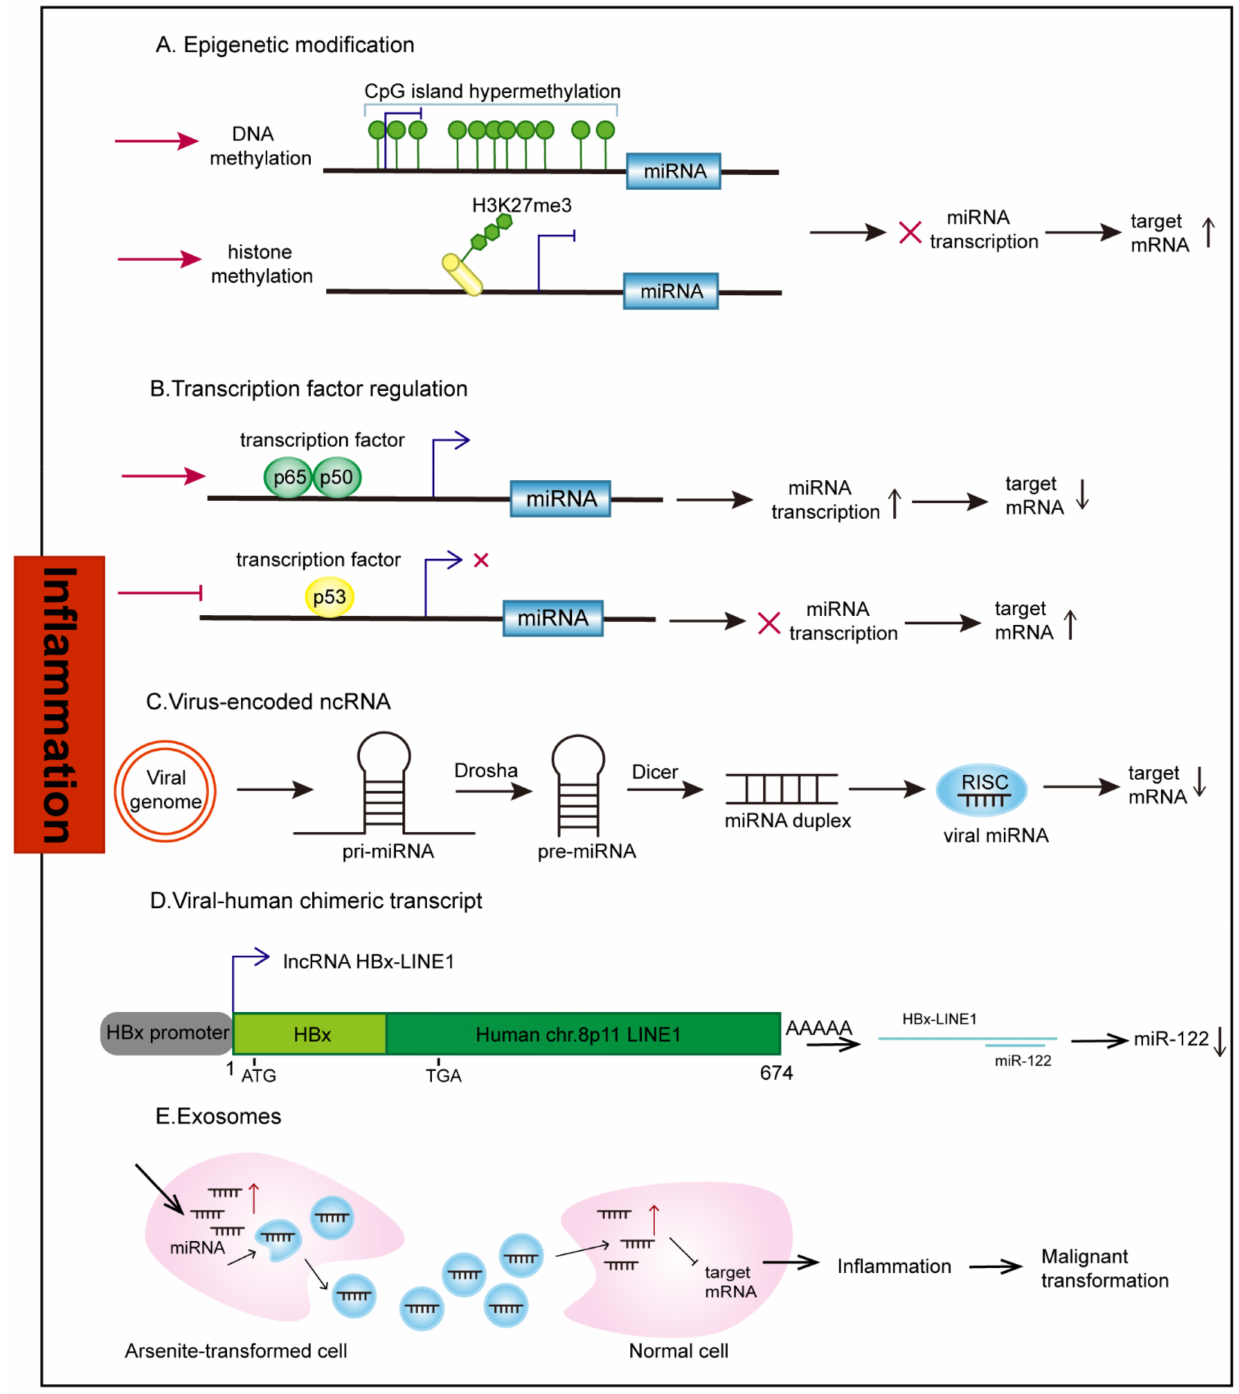
Figure 2. Mechanisms of ncRNA dysregulation under inflammation. ( A ) The alteration in the epigenetic modifications of ncRNAs is involved in ncRNA dysregulation under inflammation. Specifically, CpG island hypermethylation or histone methylation-associated silencing of miRNAs causes an upregulation of their target mRNAs. ( B ) TFs bind to the promoter of ncRNAs to transcriptionally regulate their expression. ( C ) Viral genome with DNA components uses the host’s biochemical mechanism to encode viral ncRNAs. ( D ) HBx-LINE1, which is transcribed by the viral HBX promoter, can serve as a molecular sponge for sequestering miR-122. ( E ) Exosome-derived miRNAs from arsenite-transformed cells are transferred into normal cells via exosomes to increase miRNA levels in uninfected cells and induce arsenite-induced malignant